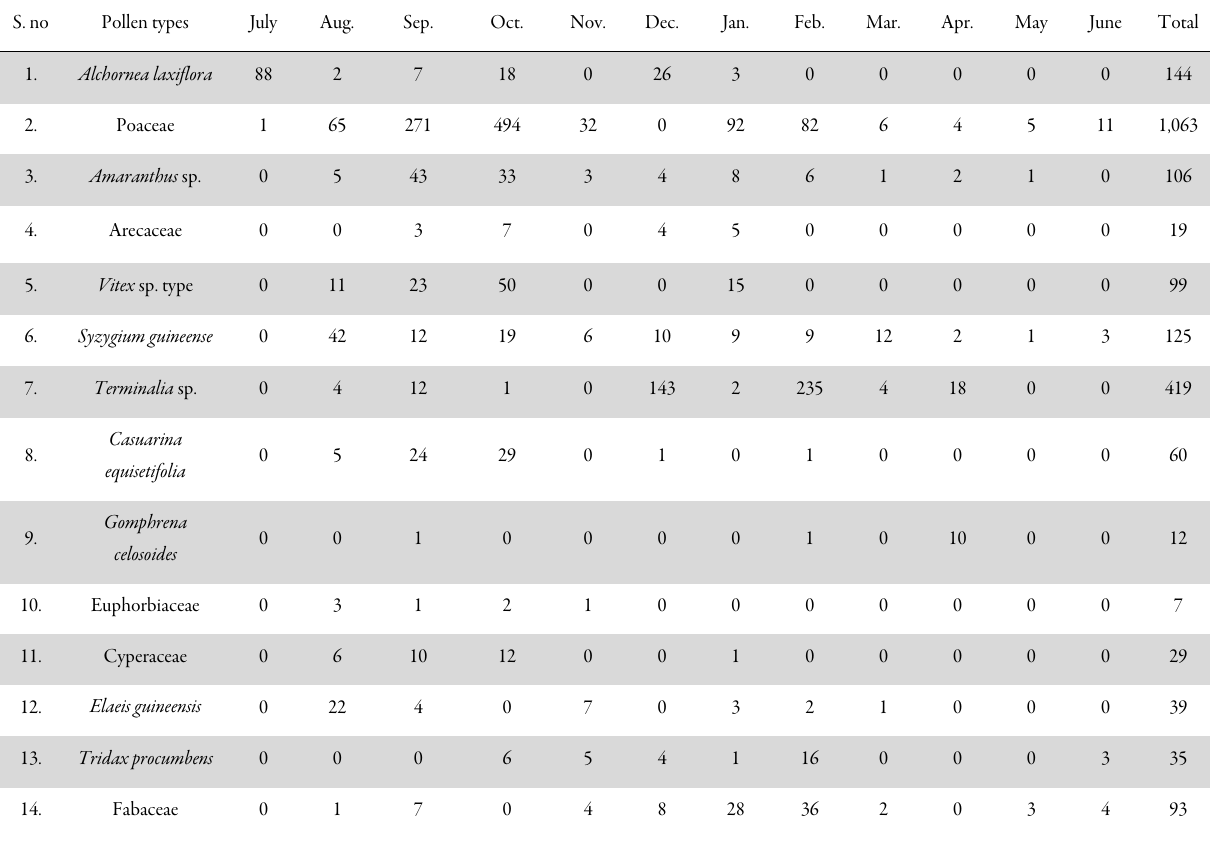
Table 1. Frequency of atmospheric pollen and fern spores recovered from the study location in Kaduna State, Nigeria (July 2015 to June 2016) S.